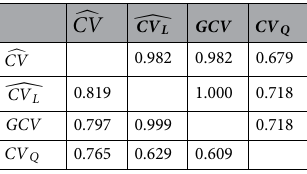
Table 1. Correlations between within-species relative variation of SLA with (upper half-matrix) and without (lower half-matrix) excluding outliers.